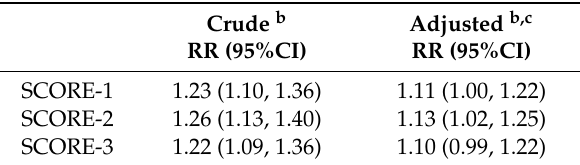
Table A1. Di ff erent combinations of the dietary risk score and the risk of gestational diabetes mellitus (GDM) a .